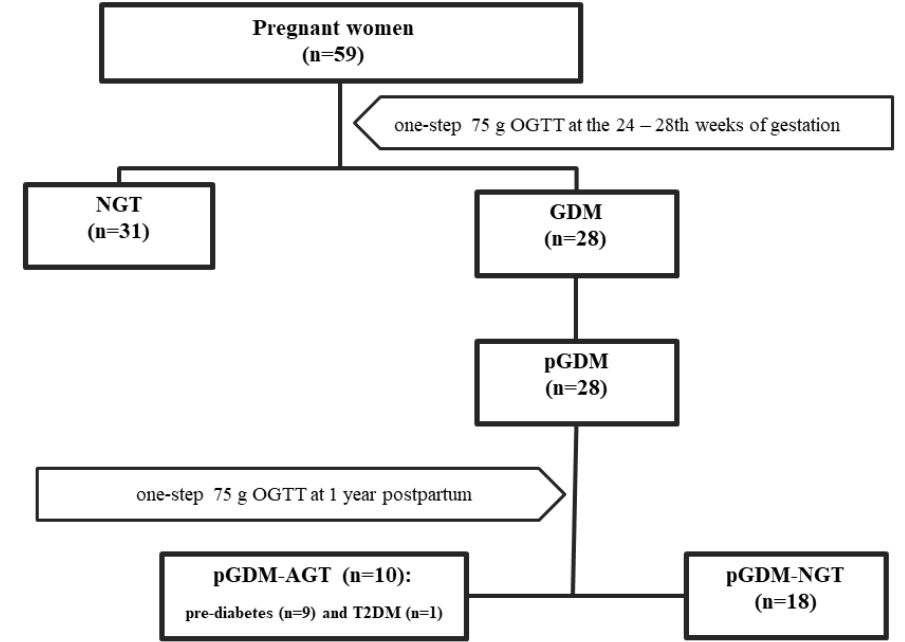
Figure 1. The classification of the study subjects during and after pregnancy based on the OGTT